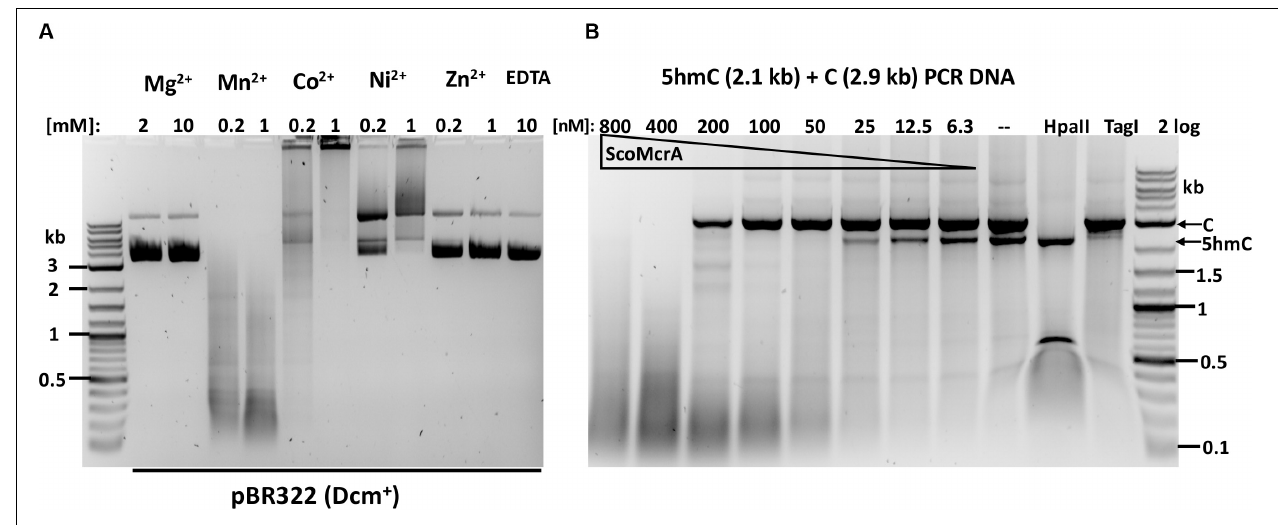
FIGURE 1 | ScoMcrA divalent cation requirements and activity on mixed PCR fragments. (A) pBR322 [Dcm + , 1 µ g (7 nM)] was digested by 50 nM of ScoMcrA in 50 mM NaCl buffer, supplemented with different divalent cations. Digestion in Co 2 + ions formed a brown precipitate (some DNA was stuck in the loading well) even after Proteinase K treatment. The banding pattern in Mn 2 + buffer suggests cleavage specificity. (B) ScoMcrA digestion of two PCR fragments (2.9 kb unmodified DNA and 2.1 kb 5hmC-containing DNA). Hpa II digests unmodified DNA only; TagI, preferentially cleaves 5hmC-modified DNA. 2 log: 0.1–10 kb DNA ladder